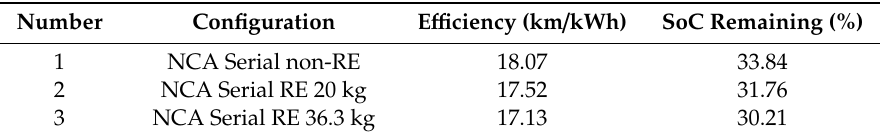
Table 10. Most e ffi cient configuration for the first route.